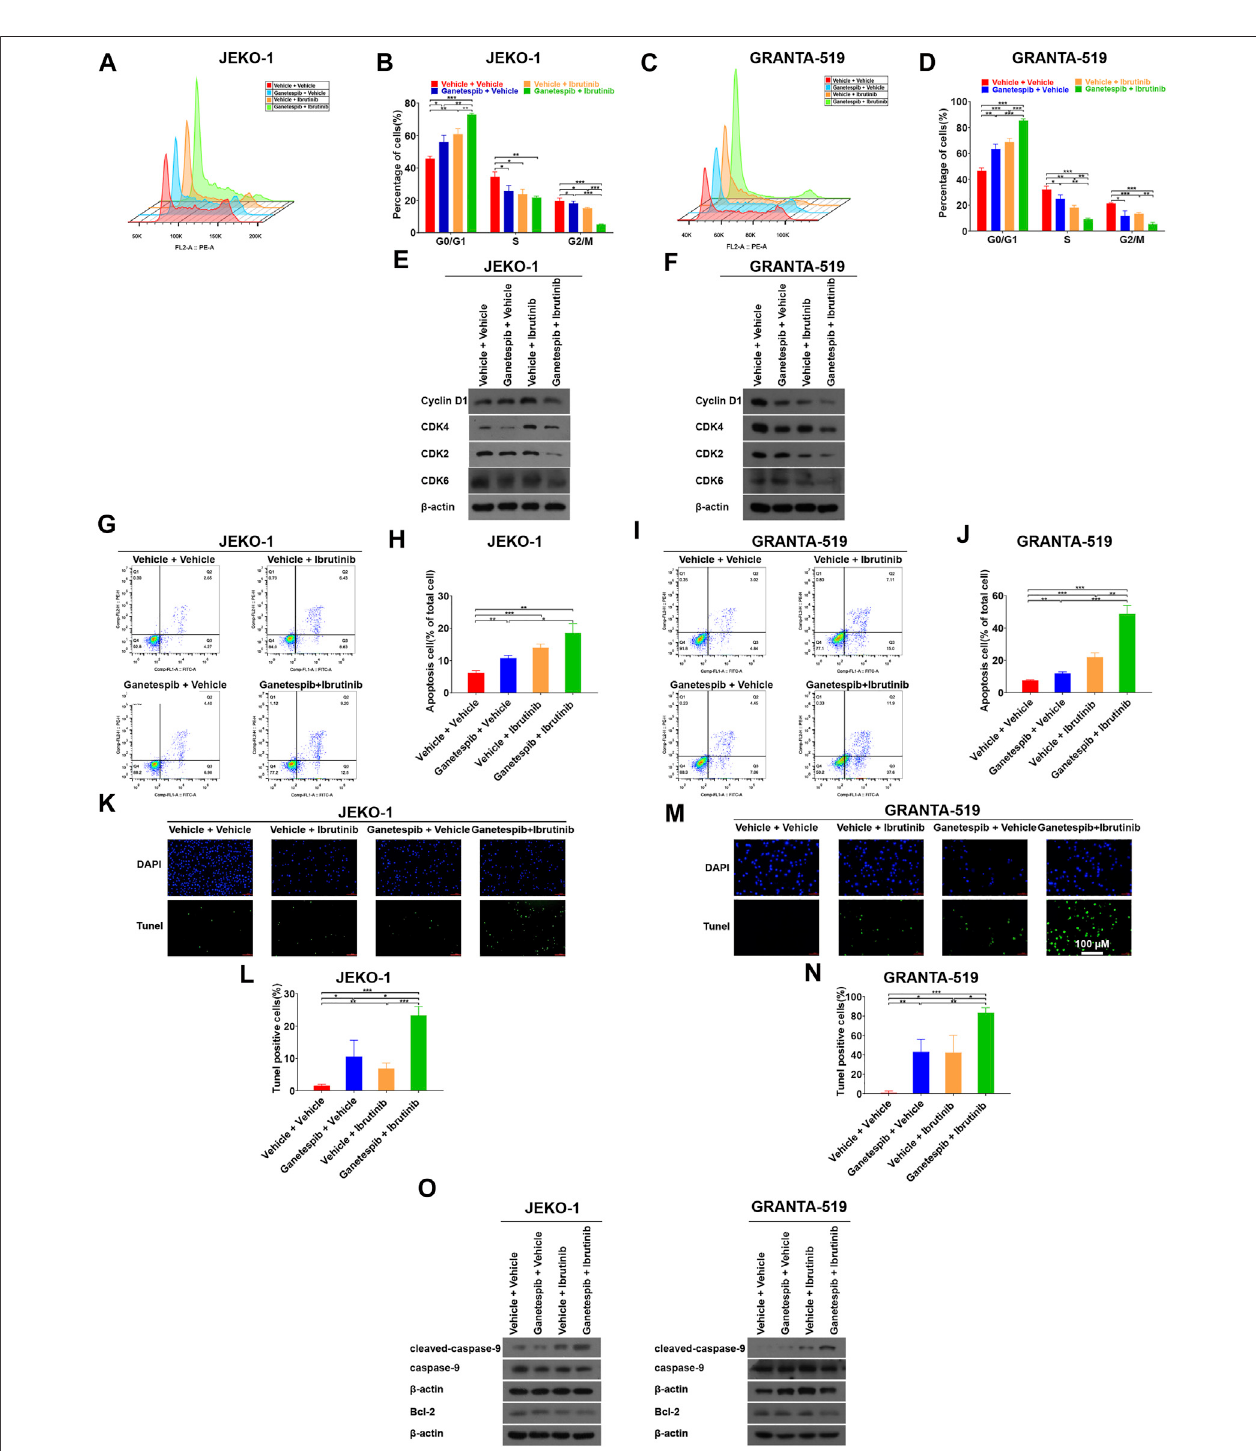
FIGURE 2 | Pretreatment with ganetespib enhanced cell cycle arrest and cell apoptosis induced by ibrutinib. Jeko-1 and Granta-519 cells were treated with ganetespib (15 nM for Jeko-1 and 45 nM for Granta-519 cells, respectively) for 12 h, and then treated with either ibrutinib at 6 μ M or vehicle for 12 h before cell cycle assays (A – D) or subjected to WB (E – F) . (A,B) Representative fl ow cytometry plots and statistics of cell cycle distribution for Jeko-1 cells. (C – D) Representative fl ow cytometry plots and statistics of cell cycle distribution for Granta-519 cells. (E,F) . Protein lysates of Jeko-1 (E) and Granta-519 cells (F) were subjected to immunoblot analysis with the indicated antibodies of cell-cycle markers. (G – J) Jeko-1 and Granta-519 cells were treated with ganetespib (15 nM for Jeko-1 and 45 nM forGranta-519cells,respectively)for12 h, andthentreatedwitheitheribrutinibat6 μ Morvehiclefor60 hbeforeapoptosisassays.Representative fl owcytometryplots